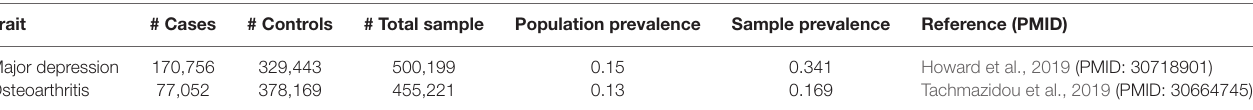
TABLE 1 | Summary of GWAS